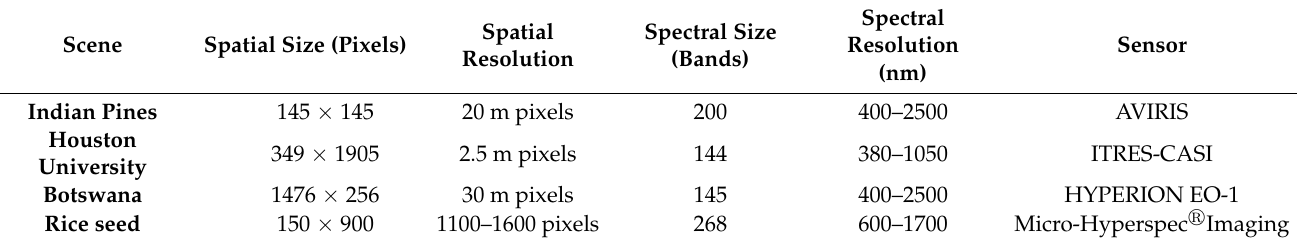
Table 2. Hyperspectral dataset